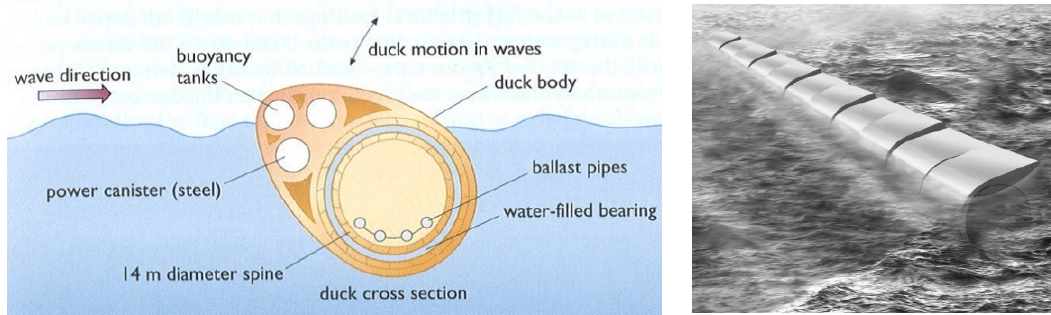
Figure 23. Salter’s Nodding Duck. Section ( left ) [81] and rendering view ( right ) (reproduced with license n. 5154830518763 from [80], Elsevier, 2007).